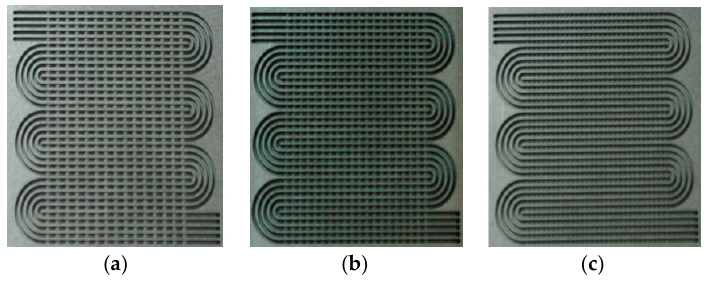
Figure 6. Bipolar plates of the gas flow cathode channels with the three wave form expansion ratios (ERs) of ( a ) ER 1.5, ( b ) ER 2.0, and ( c ) ER 3.0.